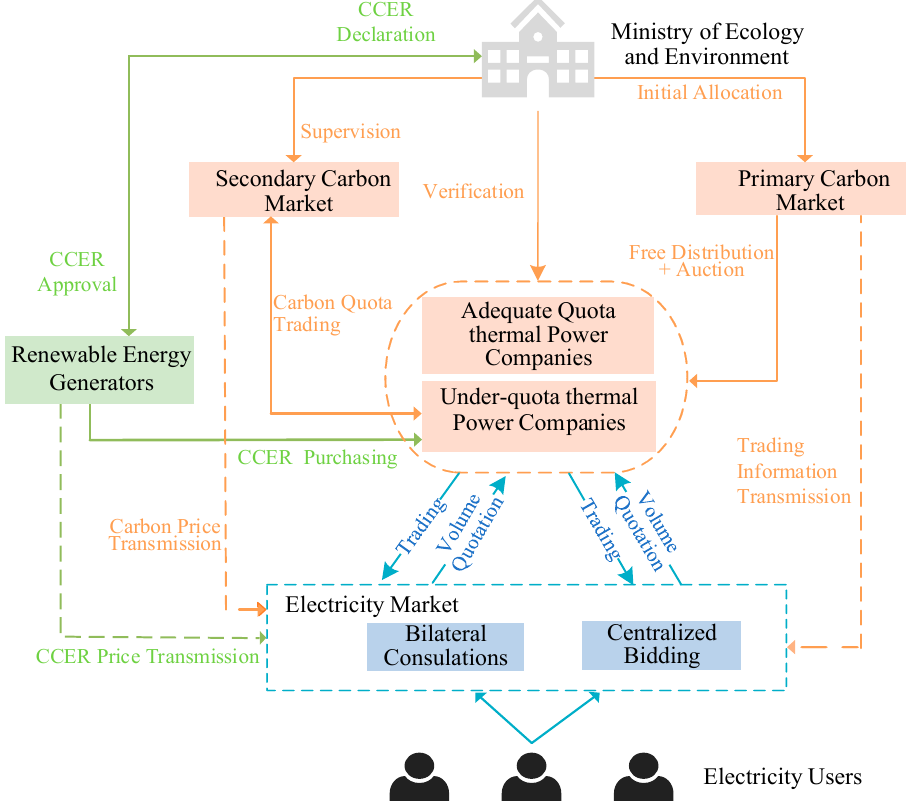
Figure 3. Coupling mechanism of power–carbon market.